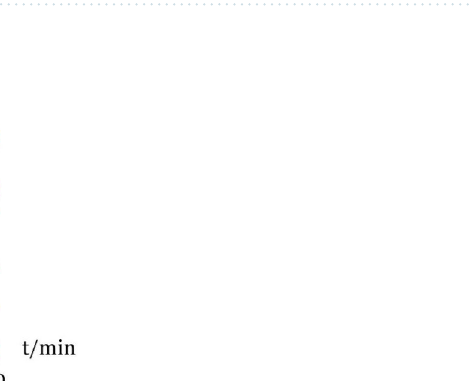
Figure 2. Sensitivity evaluation through the analysis of ten-fold serial dilutions (Dil.1 – Dil.10) of pure D. polymorpha DNA with initial concentration of 567.30 ng/µL performed using GraphPad Prism version 8.0.0 for Windows, GraphPad Software, San Diego, California USA, www. graph pad. com: (red line) Dil.1, (light blue line) Dil.2, (deep red) Dil.3, (orange) Dil.4, (fucsia line) Dil.5, (purple line) Dil.6, (dark blue line) Dil.7, (dark green line) Dil.8, (green line) Dil.9, (yellow line) Dil.10. ( a ) qPCR method with hydrolysis probe; ( b ) qPCR method with F3/B3 primers. ΔRn is the magnitude of the signal generated, being given by the normalized reporter (Rn) subtracted by the baseline.